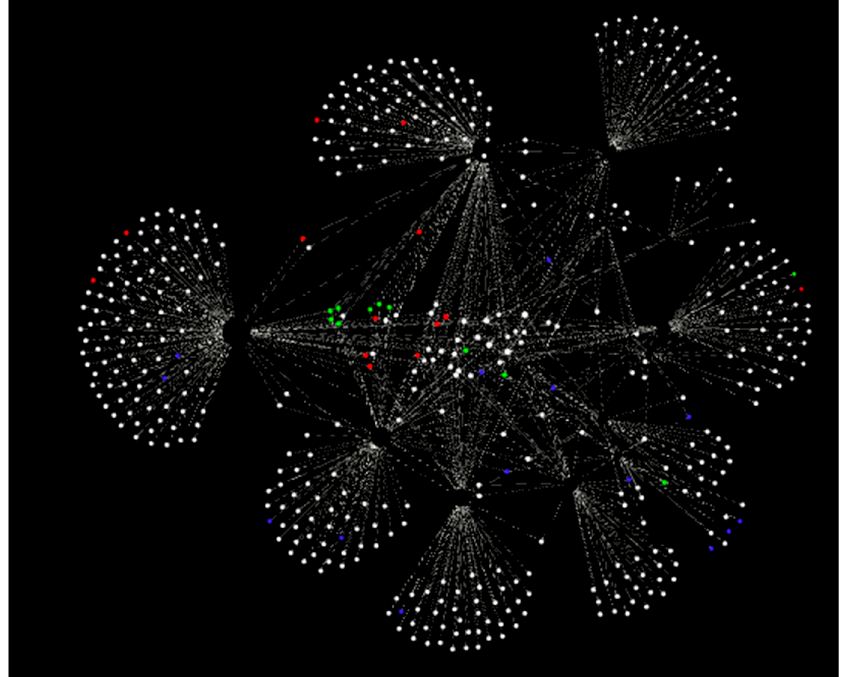
Figure 3. Historical figures (generals in red, poets in green, and Confucians in blue).